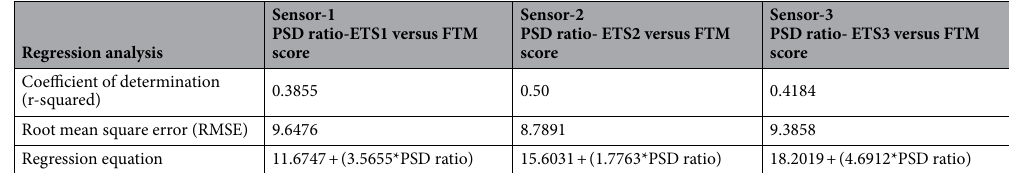
Table 2. Regression analysis of PSD ratio vs FTM score at the three sections of the arm.